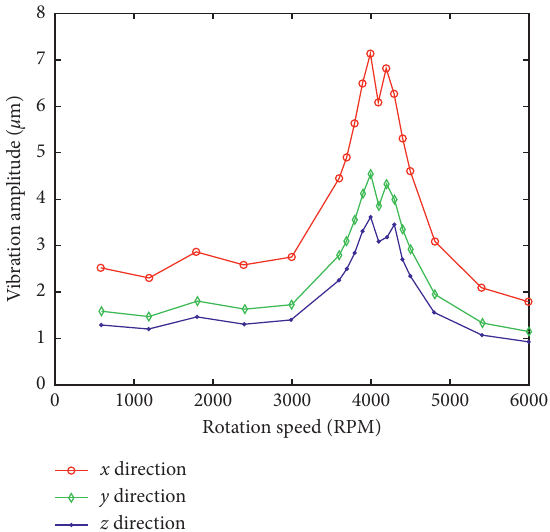
Figure 8: Influence of input rotation speed of drive shaft on vibration of the main reducer [29].